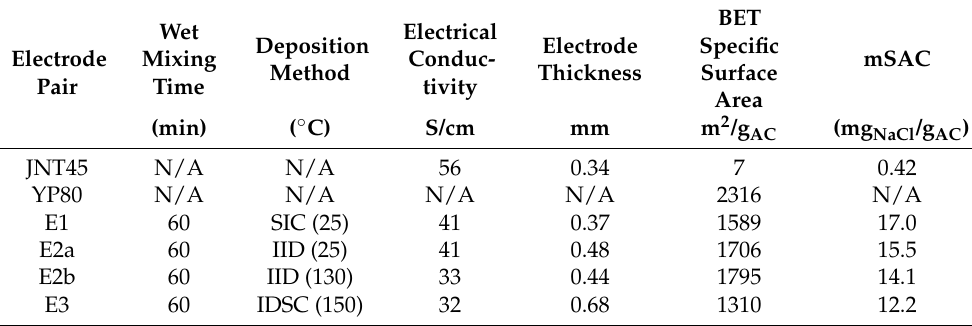
Table 1. Electrodes produced using slurry infiltration by calendering (SIC), ink infiltration dropwise (IID) and ink deposition by spray coating